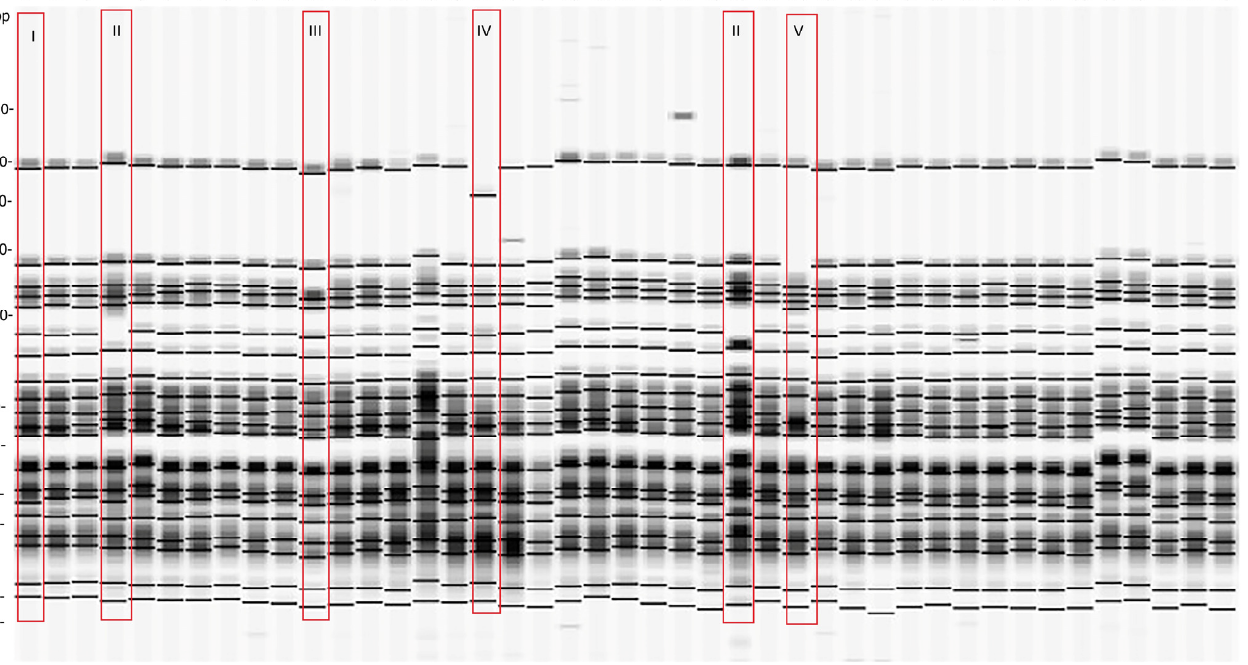
Figure 2. Pulsed-field gel electrophoresis pulsotypes of 43 Y. enterocolitica isolated strains after restriction with Spe I. Five pulsotypes were observed (surrounded by red rectangles). Pulsotypes II, III, IV, and V differ from the major pulsotype I, which is representative of all analyzed strains except strains 4, 11, 17, 26, and 28. The number of each lane corresponds to the number of the analyzed Y. enterocolitica strain (1–43). The pulse marker used was 50–1000 kb.